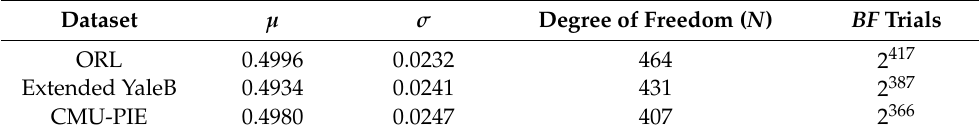
Table 4. Degree of freedom computation for the mapped binary code at the length of 1024 bits.